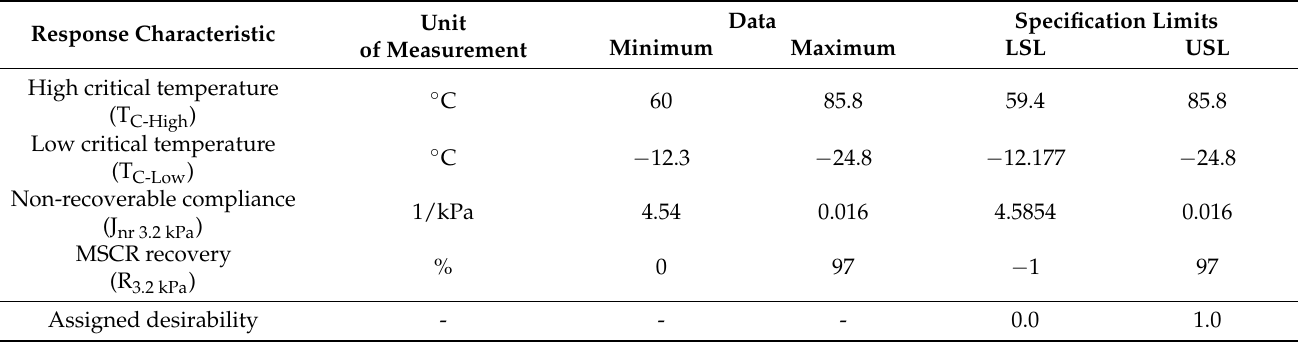
Table 7. The specification values of desirability functions used in the